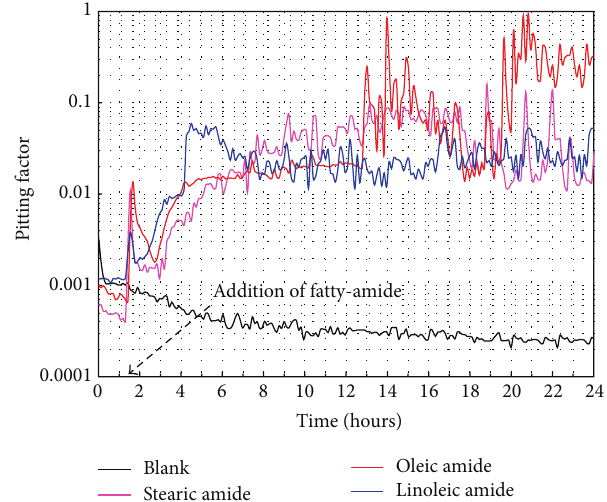
Figure 18: Variations of PF data with time for 1018 carbon steel exposed to CO 2 -saturated (3% NaCl + diesel) emulsion at 50 ∘ C,with the different